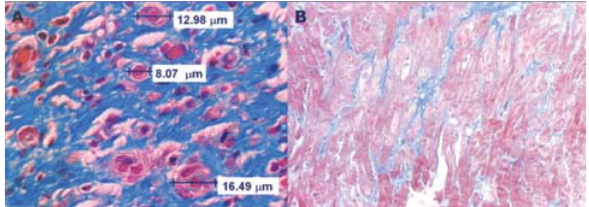
Fig. 1 - (A, left) Histological aspect of canine myocardium treated with plasmidial VEGF , prepared for the evaluation of vessel 165 density. Vessels count and diameter were done through an electronic automated program. There was a significant increase in capillaries, defined as vessels under 25 micra in diameter, in all myocardial areas, but more pronounced in the transition area between ischemic and normal myocardium. Stain: haematoxylin-eosin. (B, right): Histological aspect of infracted canine myocardium, where areas of fibrosis (gray-blue stained areas) are demonstrated.